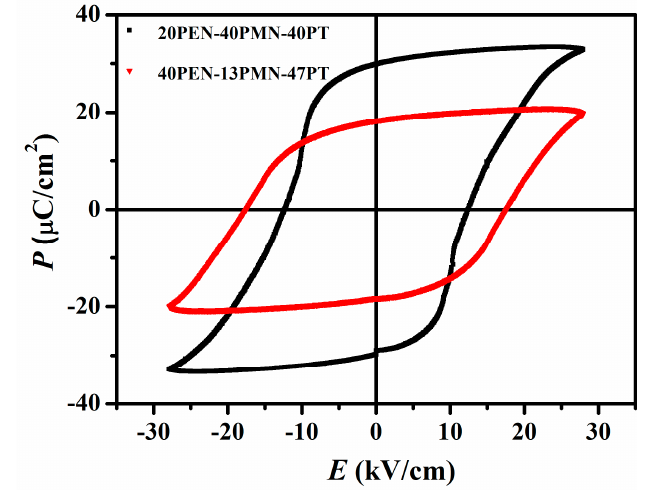
Figure 5. Ferroelectric hysteresis loop of [100]-oriented PEN-PMN-PT: crystal: ( a ) 20PEN-40PMN-40PT; ( b ) 40PEN-13PMN-47PT.